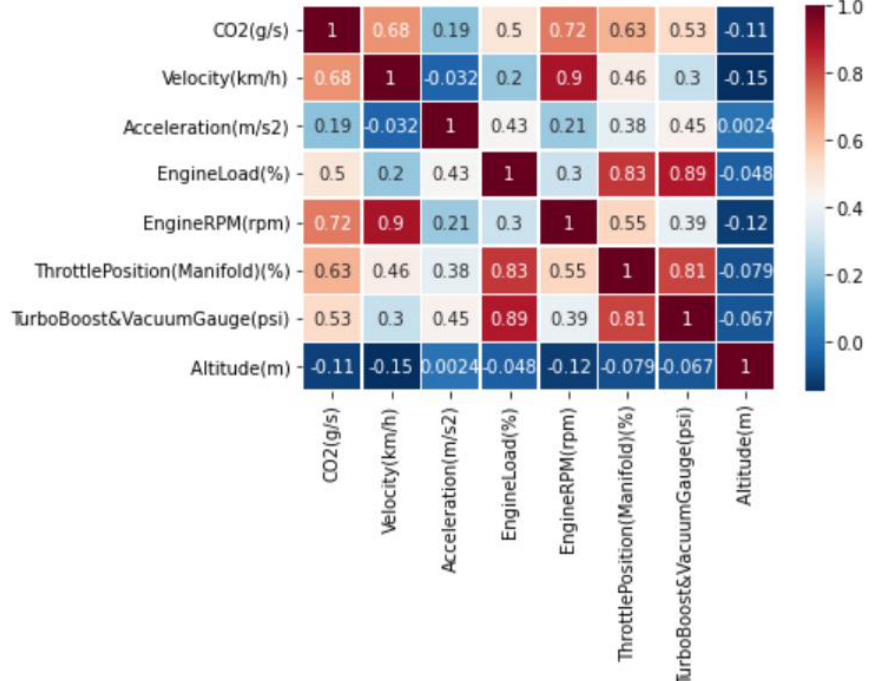
Figure 5. Pearson’s correlation coefficient results for the LPG vehicle parameters tested .